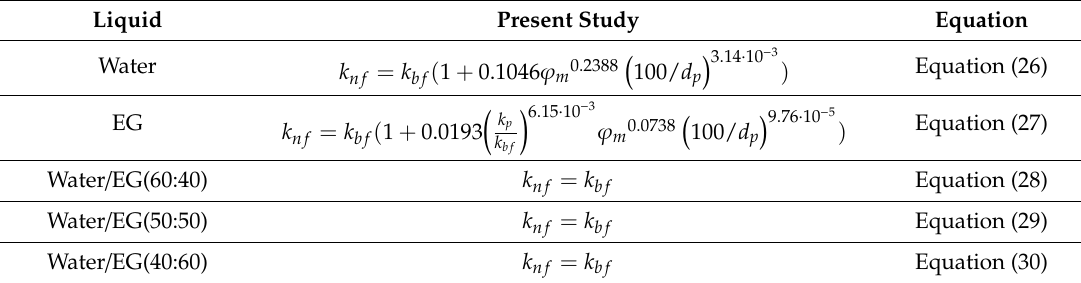
Table 5. Correlations for the thermal conductivity of the tested